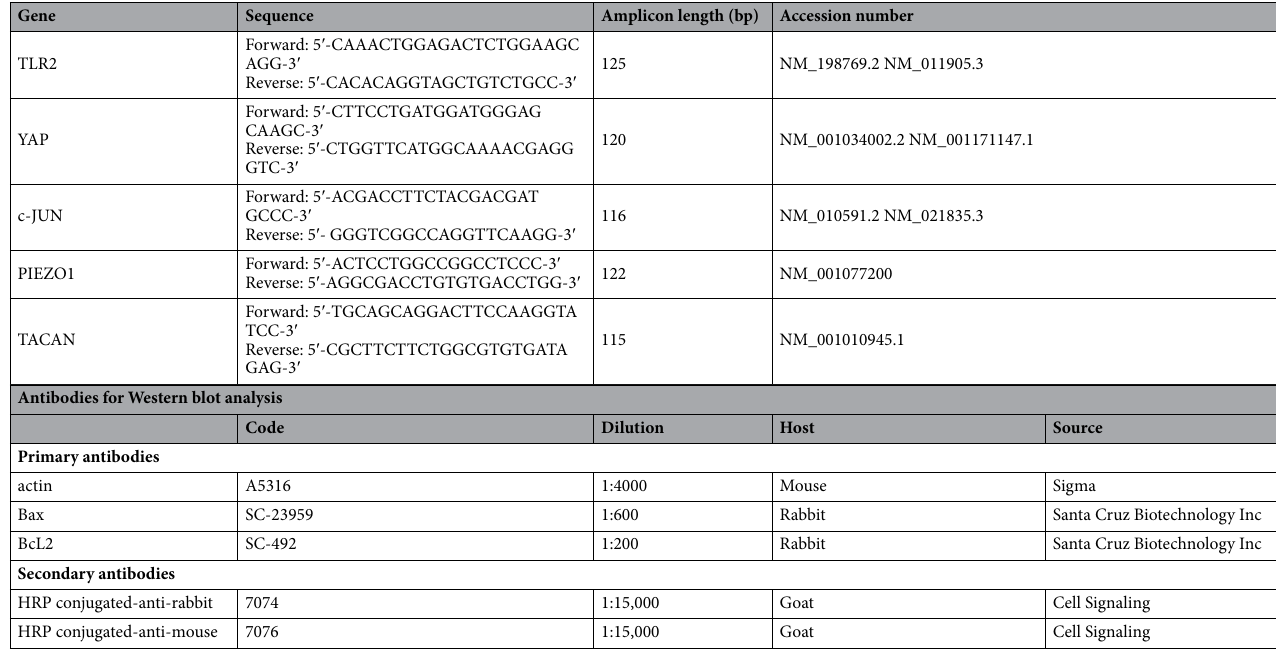
Table 2. Sequences of primers used for quantitative real-time PCR and antibodies used for western blot